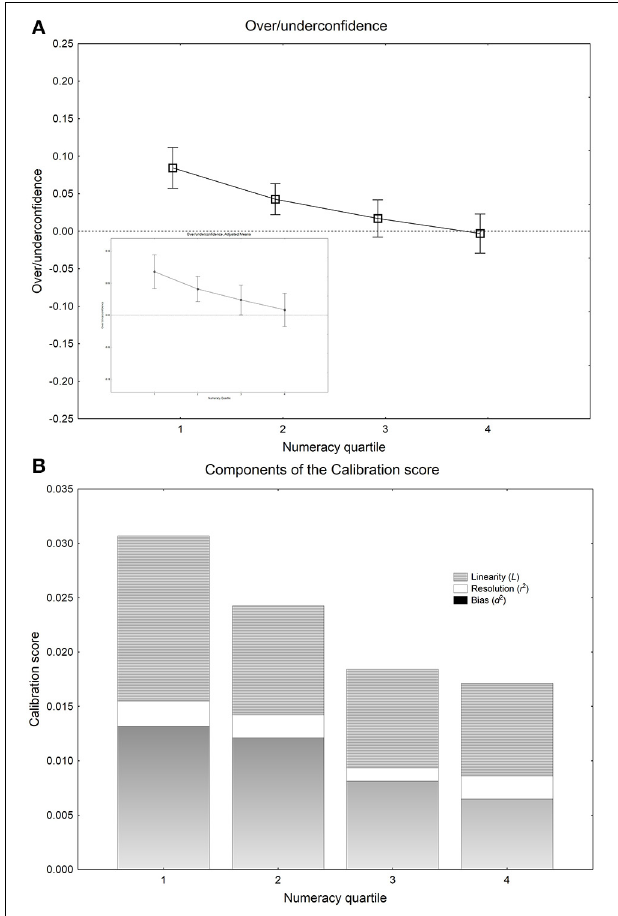
FIGURE 3 | (A) The mean over/-underconfidence score with 95% confidence intervals plotted as function of the four numeracy quartiles. The dotted line is zero over/underconfidence. The small inserted panel shows the corresponding means with 95% confidence intervals, after adjustment for the effects of potentially confounding variables (see the main text). (B) The mean calibration score, where the areas indicate the portion of miscalibration contributed by each of the three additive components of the total Calibration score C (see Björkman, 1992).